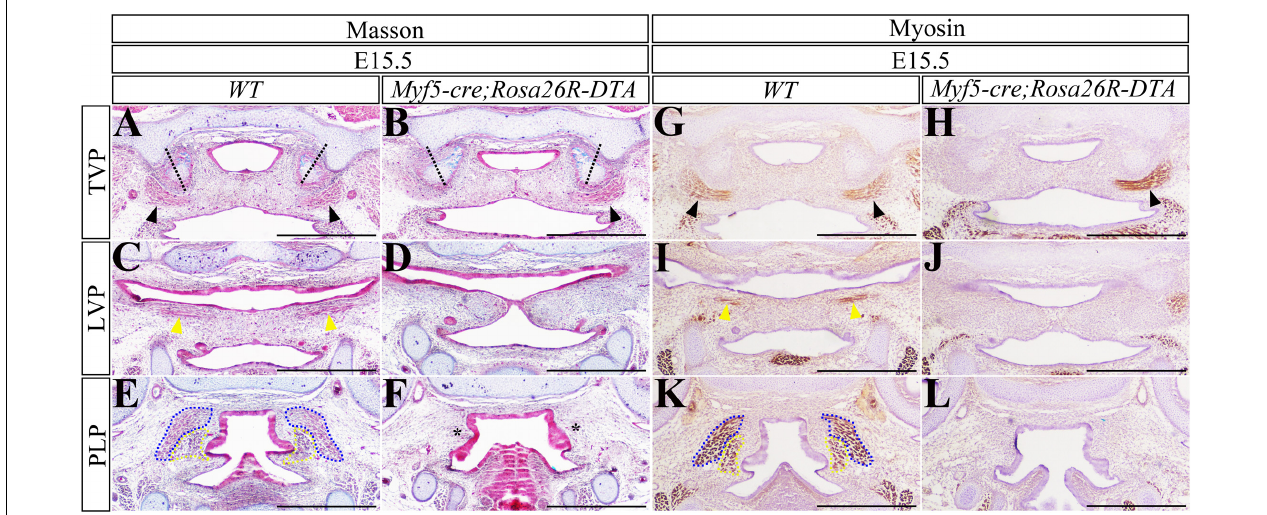
FIGURE 7 | The fusion of Myf5-cre; Rosa26R-DTA soft palate. (A–F) Masson staining of the E15.5 WT and Myf5-cre; Rosa26R-DTA soft palates. The WT TVP (A) , LVP (C) , and PLP (E) levels were compared with the Myf5-cre;pMes-Noggin TVP (B) , LVP (D) , and PLP (F) levels. (G–L) The immunostaining of myosin of the E15.5 WT and Myf5-cre; Rosa26R-DTA soft palates. The WT TVP (G) , LVP (I) , and PLP (K) were compared with the Myf5-cre;pMes-Noggin TVP (H) , LVP (J) , and PLP (L) levels. The black dashed lines indicate the orientation of HPPs; the black arrowheads delineate to TVPs; the yellow arrowheads point to LVPs; the blue dotted lines circle SPCs; the yellow dotted lines mark PLPs. Scale bars are 200 µ m. TVP, tensor veli palatini; LVP, levator veli palatini; PLP, palatopharyngeus; HPP, hypophosphatasia; SPC, superior pharyngeal